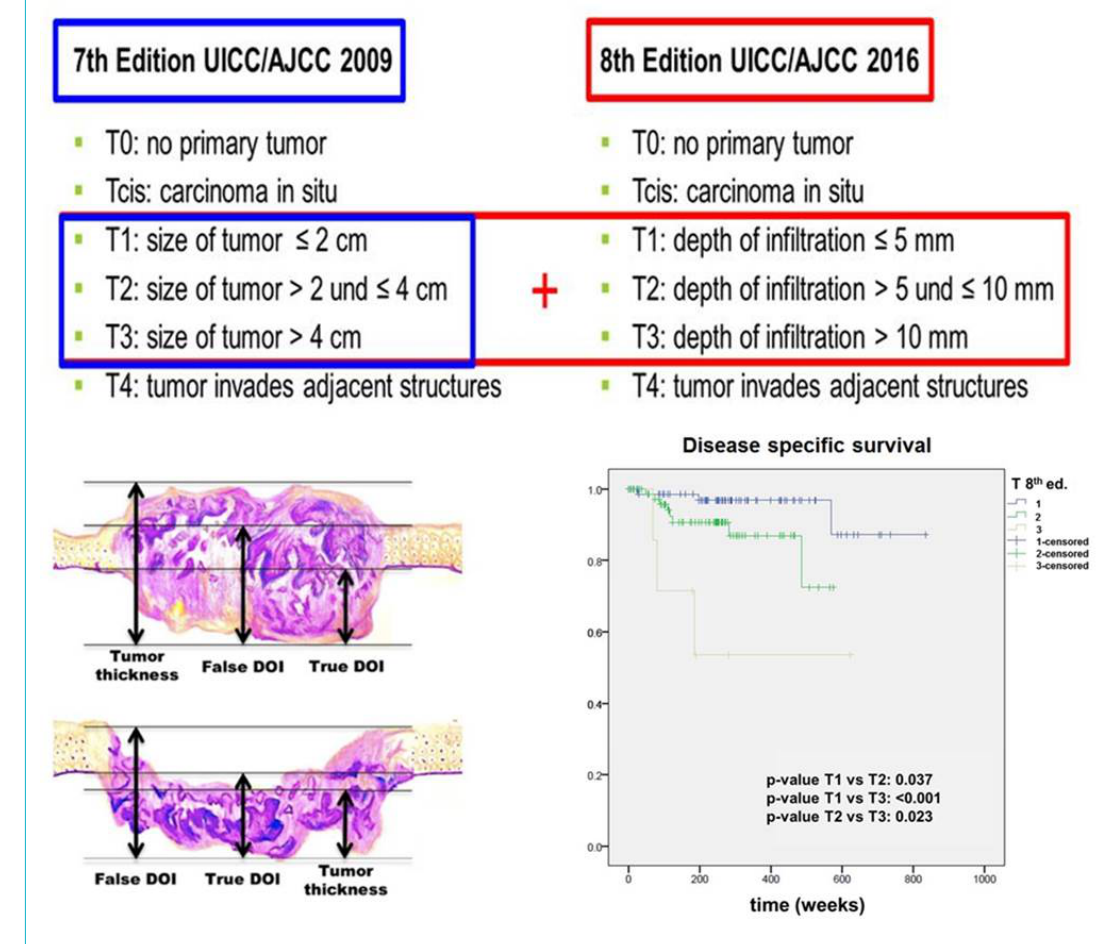
Figure 1: The relevant differences between the 7th and 8th editions of the UICC/AJCC staging system, the meaning of true depth of infiltration (DOI) and the enhanced discrimination of T-stage in the survival of tongue tumours by the new edition are visually